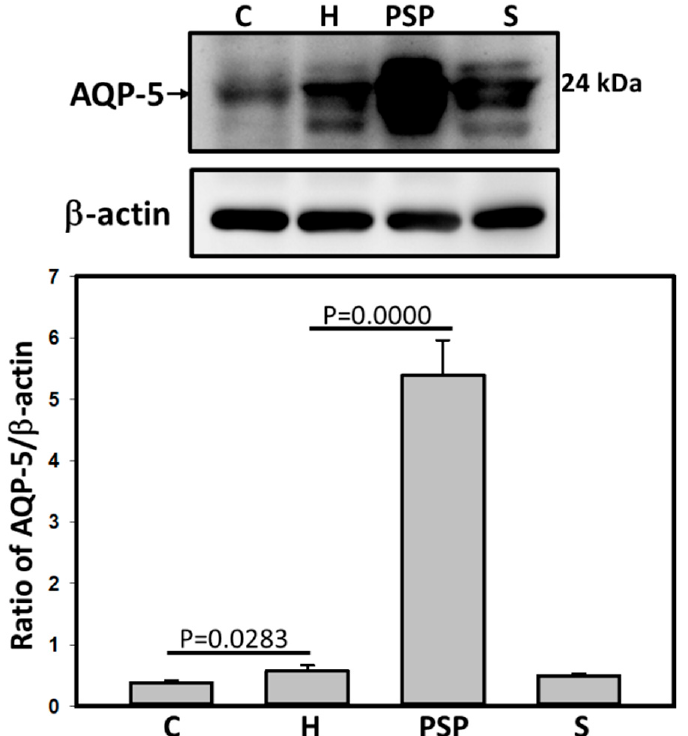
Figure 5. PSP treatment increased AQP5 level. Immunoblot examination was carried out to detect AQP5 level. The β -actin was used as the loading control. The relative image density was quantified by the densitometer. Ratio values calculated from triplicate experiments were represented as the mean ± SD shown in lower panel.